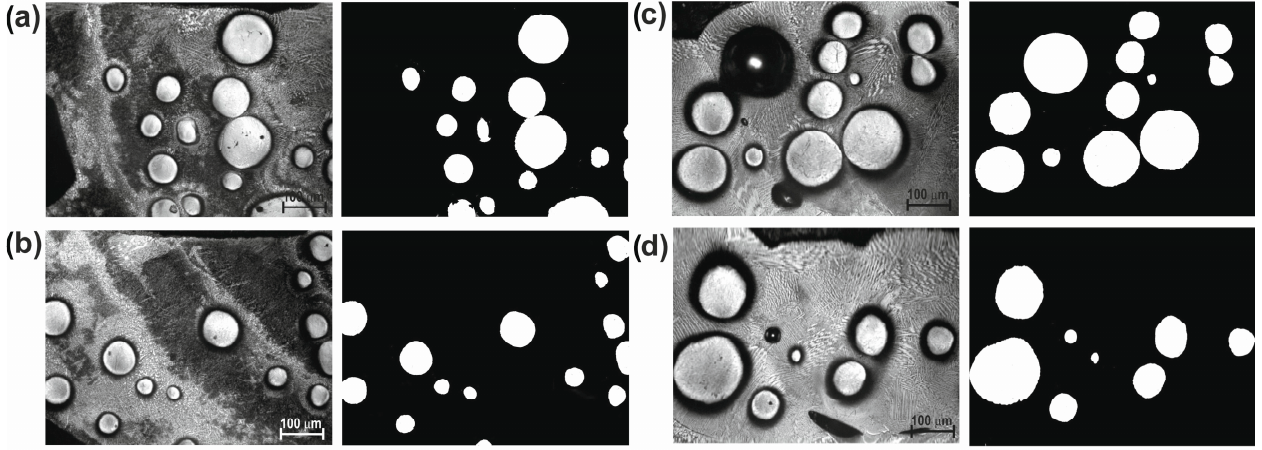
Figure 4. Four selected OM images and their binary images showing the microstructure of the la- ser-alloyed layer produced with a laser beam power of 1.3 kW: ( a ) area 1, ( b ) area 2, ( c ) area 3, ( d ) area 4.